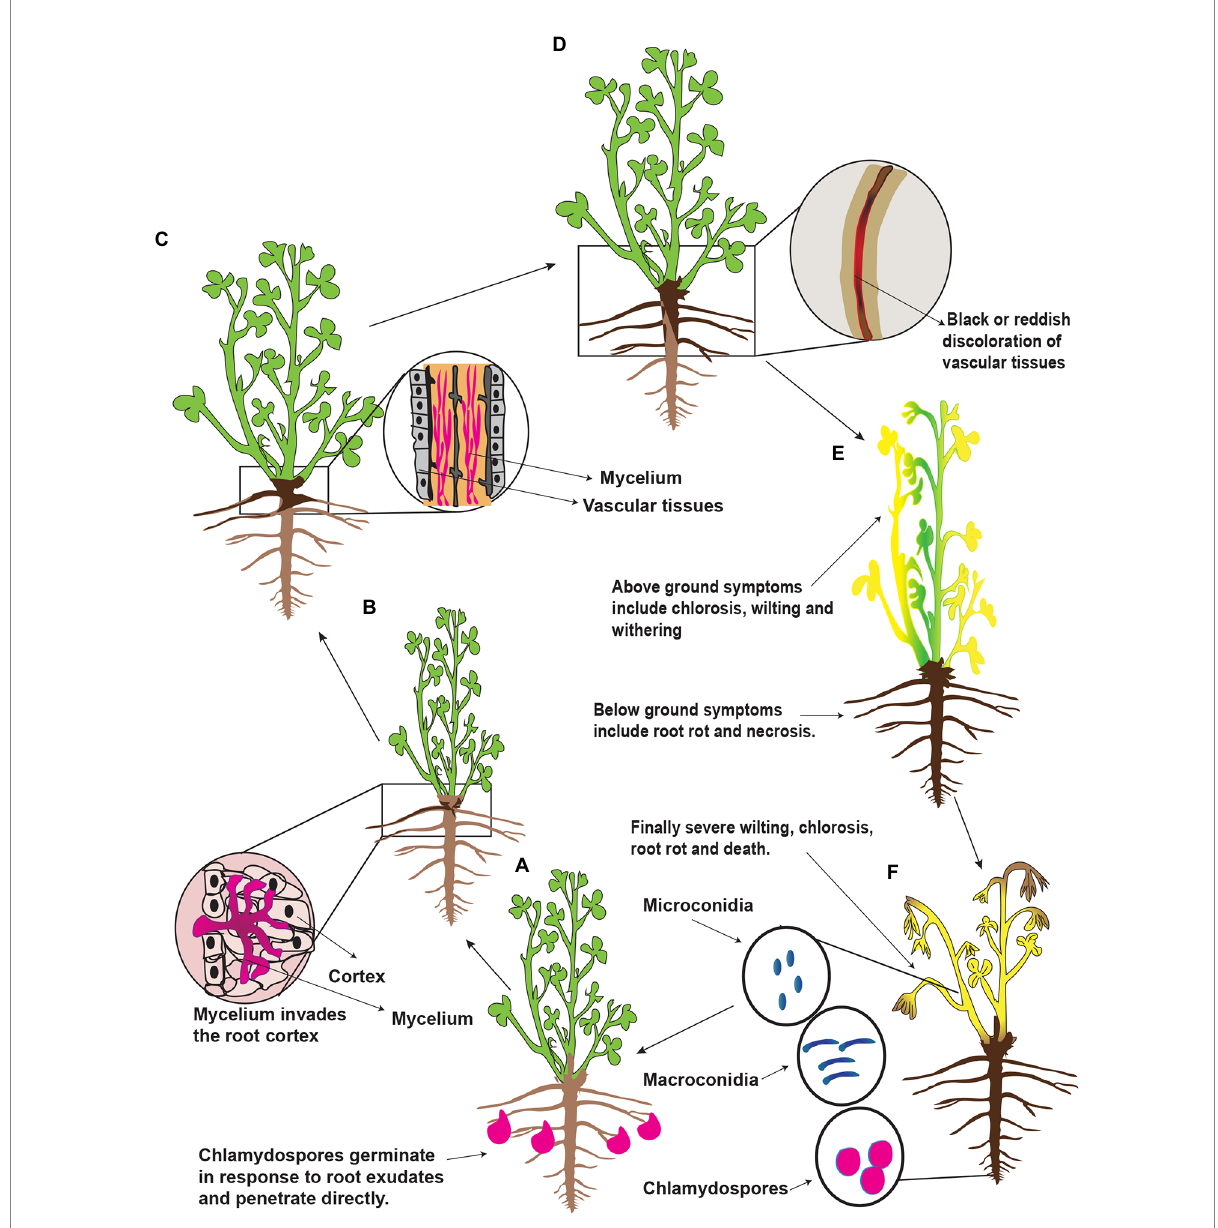
FIGURE 3 Schematic representation of the presumed disease cycle of Fusarium root rot in China. (A) Alfalfa plant secrete root exudates and in response to exudates Fusarium spp. spores (chlamydospores) germinate and produce infection hypha to penetrate the root epidermis at the root tip. (B) The hypha proliferates in the root cortex and enters into the vascular vessels, i.e., xylem vessels. (C) In the vessels, it grows excessively and causes a blockage; as a result, brown discoloration occurs. (D) First symptoms appear at the base of the stem, and then the symptoms progress upward; as a result, the young leaves withered. (E) Partial chlorosis or complete chlorosis is observed mainly on the mature leaves. (F) Finally, the whole alfalfa plants wilt because of severe root rot followed by death. Fungal spores such as microconidia, macroconidia, and chlamydospores form dead alfalfa plant tissues and remain dispersed in the